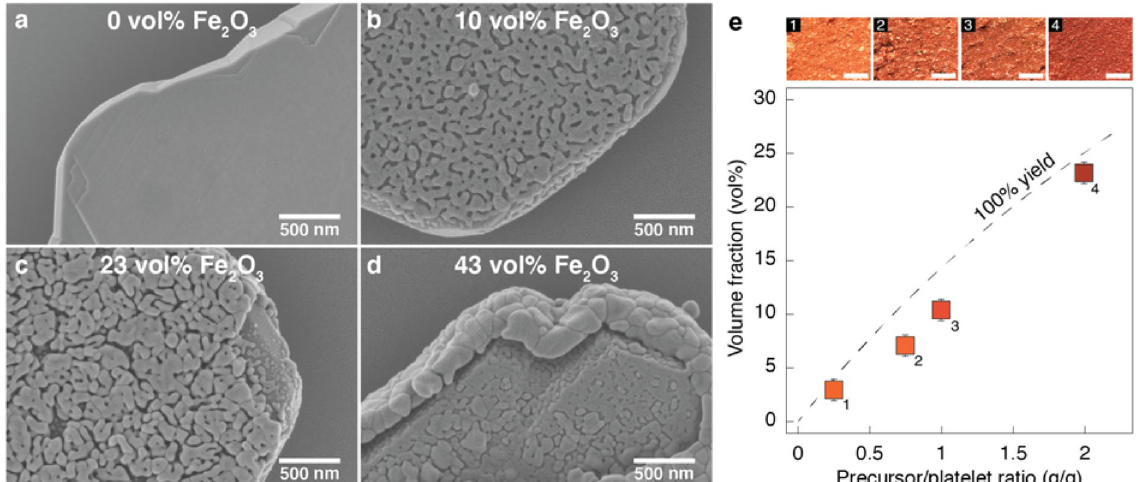
Figure 2. Alumina platelets coated with different concentration of hematite. Scanning electron micrographs of ( a ) bare platelets and of platelets coated with ( b ) 10, ( c ) 23 and ( d ) 43 vol% of hematite. The imaged platelets were obtained after the sol–gel coating procedure followed by a burn-out step. Platelets shown in ( b ) and ( c ) were prepared using precursor/platelet mass ratios of 1 and 2, respectively. The high fraction of hematite formed on the platelet displayed in ( d ) results from two successive coating reactions performed with the same powder. ( e ) Volume fraction of hematite formed on the platelet surface as a function of the initial precursor/platelet mass ratio. The dotted line indicates the predicted volume fraction if all the iron added as precursor for the sol–gel reaction is converted into oxide particles on the surface of the platelets. Optical images of the powders synthesized with increasing precursor/platelet ratios. Scale bars: 500